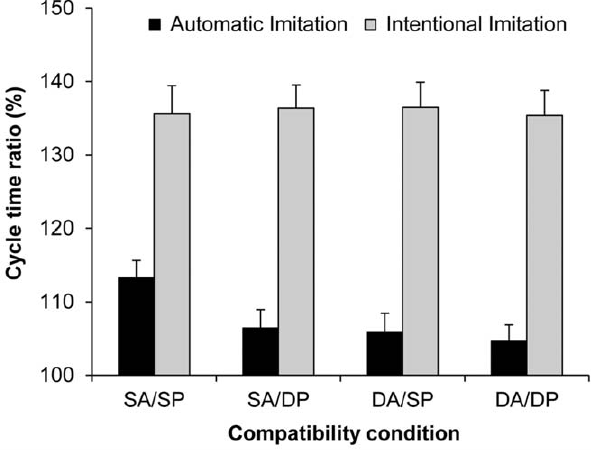
Figure 6. Automatic vs. intentional imitation: Cycle time ratios (%). Mean cycle time ratios (with standard error of the mean) for the factors intention, action type compatibility, and plane compatibility (SA=Same Action; DA=Different Action; SP=Same Plane; DP=Differ- ent Plane). The cycle time ratio in the distractor actions was 150%.